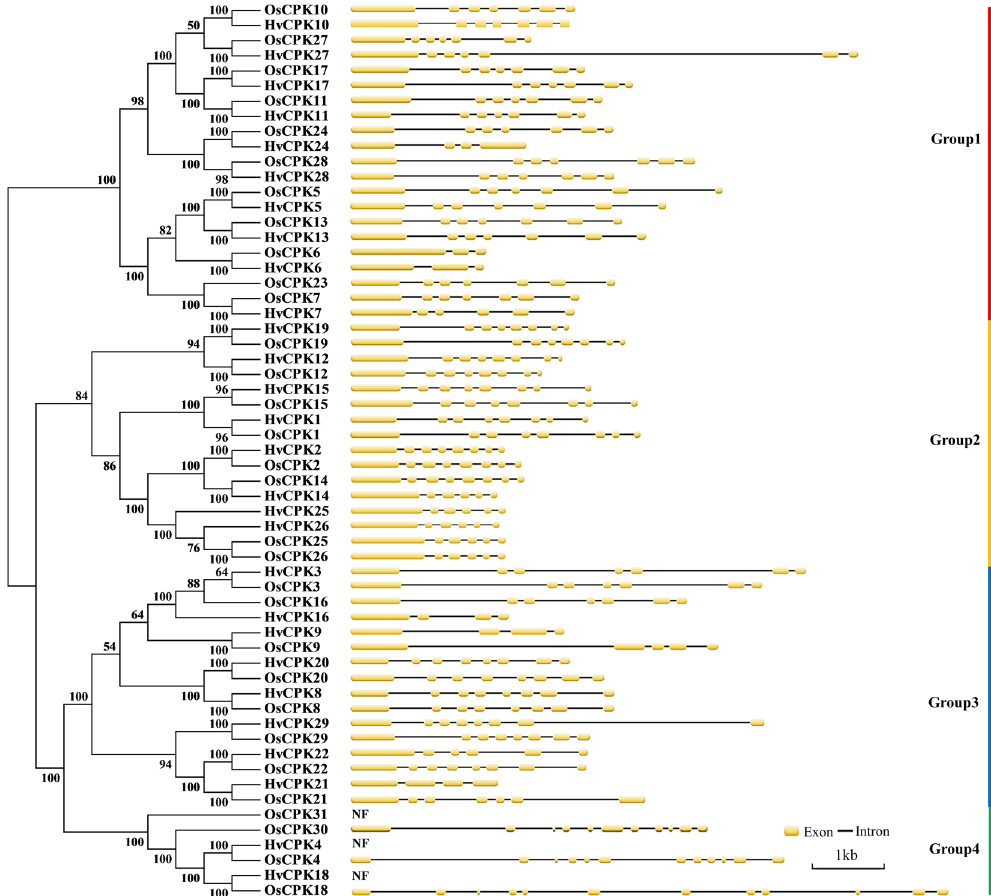
Figure 1. Phylogenetic relationships among rice and barley CDPK proteins. The molecular phylogeny was constructed from a complete protein sequence alignment of CDPKs from rice and barley using the neighbour- joining method with a bootstrapping analysis (1,000 replicates). The numbers beside the branches indicate bootstrap values. The four subgroups designated from 1 to 4 are displayed in different